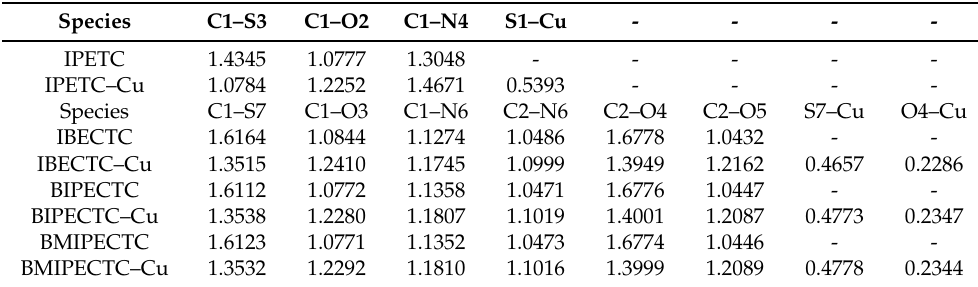
Table 5. Wiberg bond indices of the bonds in functional groups of IPETC, IBECTC, BIPECTC, BMIPECTC and the corresponding complexes.